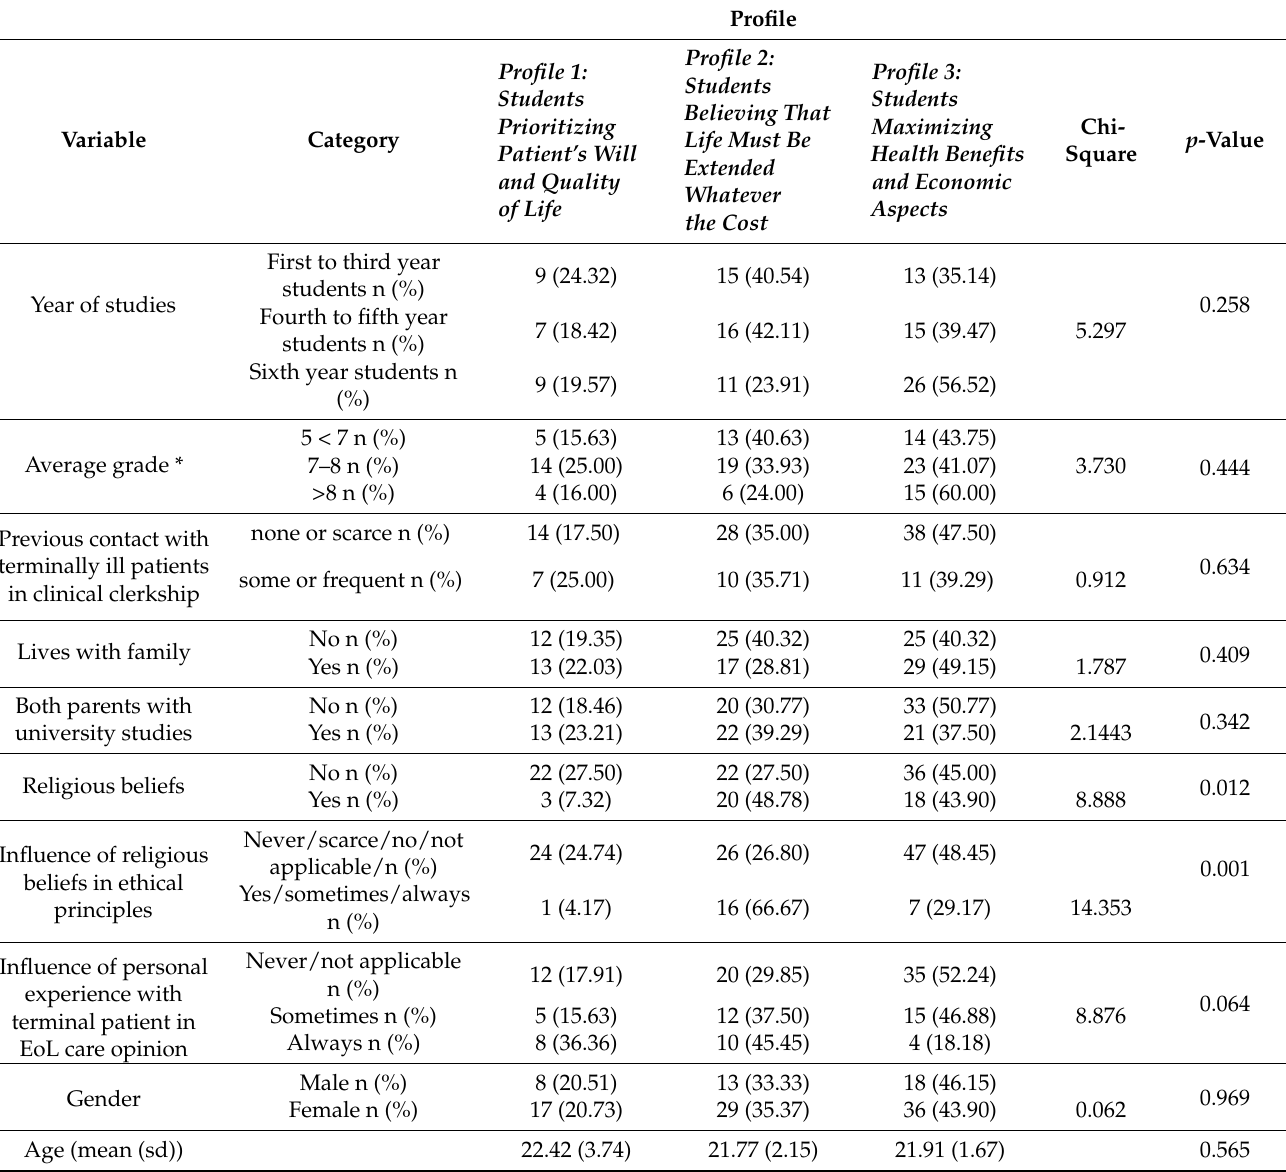
Table 3. Respondents’ characteristics associated with the